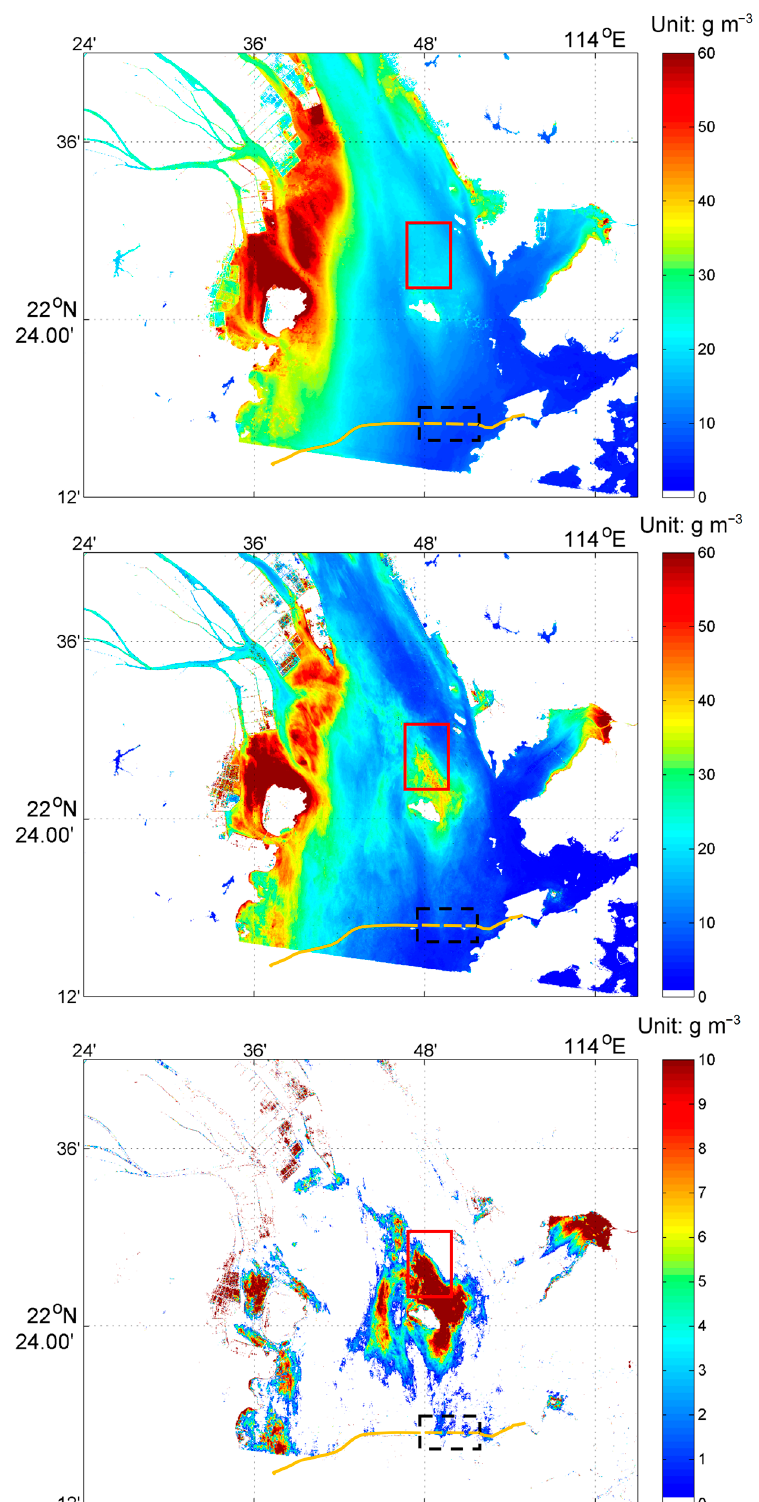
Figure 5. Mean suspended sediment concentrations during the weak/no excavation period ( top ); mean suspended sediment concentrations during the strong excavation period ( middle ); the difference between the mean suspended sediment concentrations during the strong excavation period and the weak/no excavation period. The red rectangle is the permitted sand excavation region, and the black rectangle is the tunnel construction area. The solid orange line is the bridge, and the dotted orange line is the undersea tunnel.